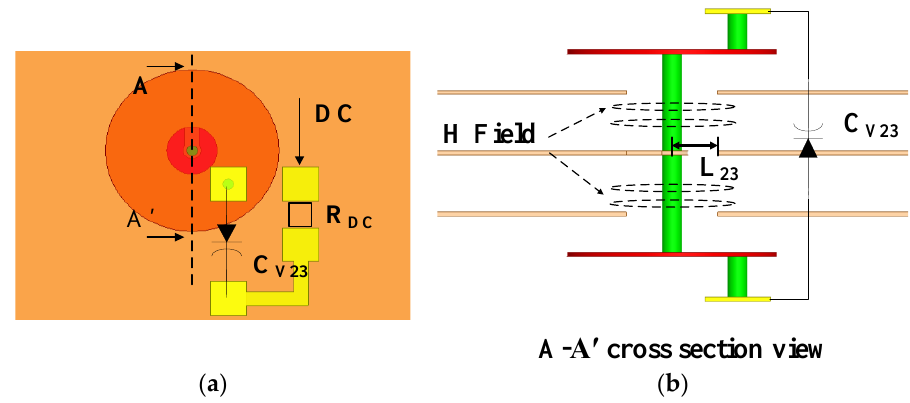
Figure 7. The coupling structure of resonators 2 and 3: ( a ) top view; ( b ) side view.